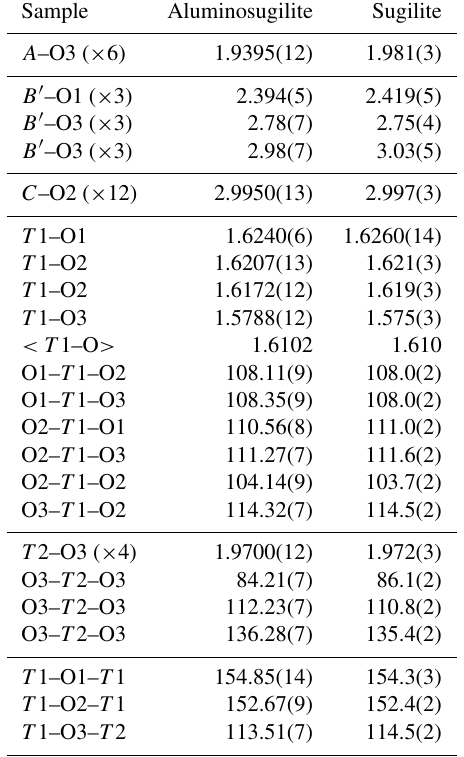
Table 4. Selected interatomic distances (Å) and angles ( ◦ ) of alu- minosugilite and sugilite.